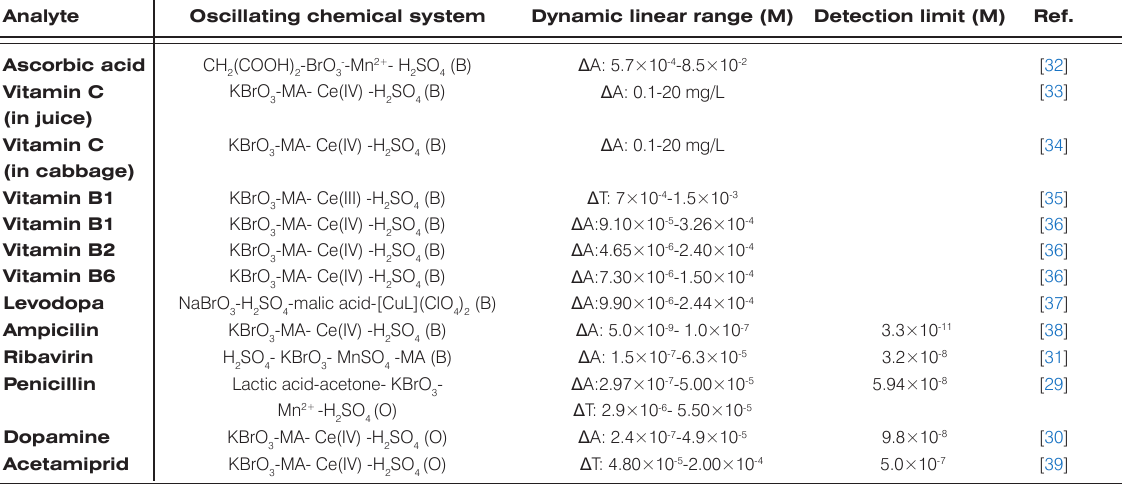
Table 2. Use of regular oscillation in medicine analysis.